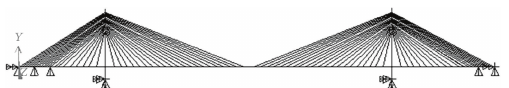
Figure 6: Boundary conditions of the Tatara cable-stayed bridge.